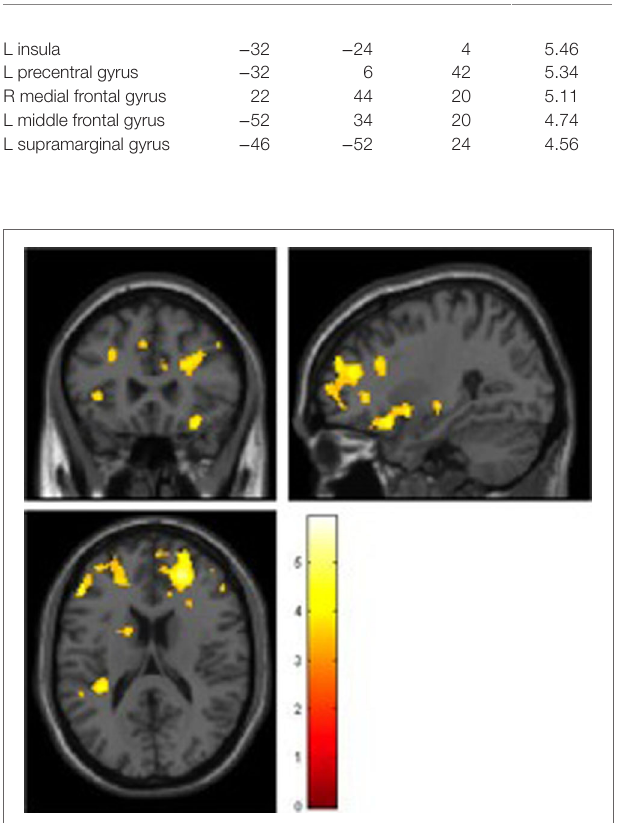
FigUre 1 | Main effect of encoding (FWe corrected) .